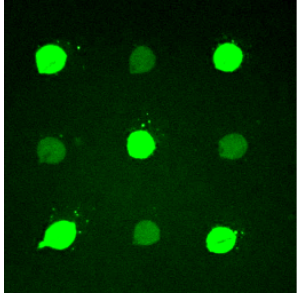
Figure 2. Hybridization to tethered oligonucleotides.